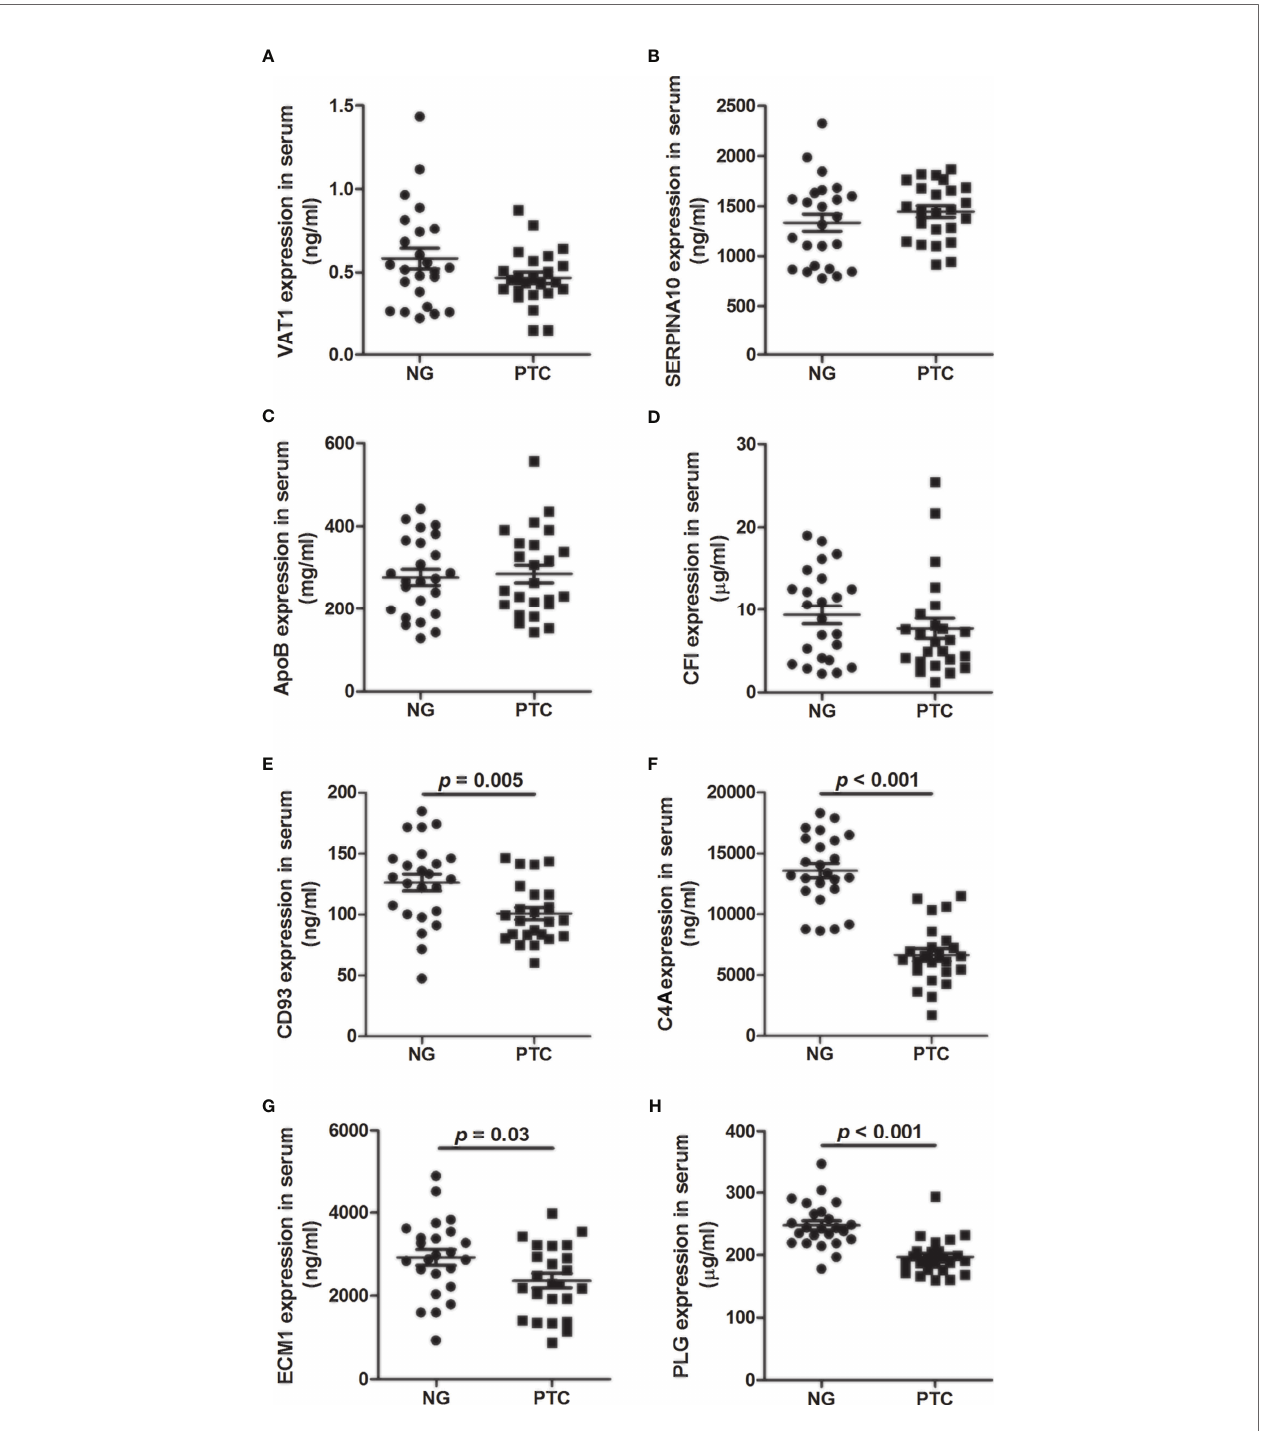
FIGURE 1 | Concentrations of (A) VAT1, (B) SERPINA10, (C) APOB, (D) CFI, (E) CD93, (F) C4A, (G) ECM1, and (H) PLG in the plasma of PTC and